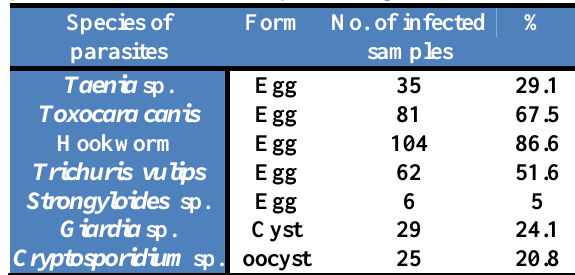
Table, 1: prevalence of intestinal parasites and protozoa in 120 fecal samples of